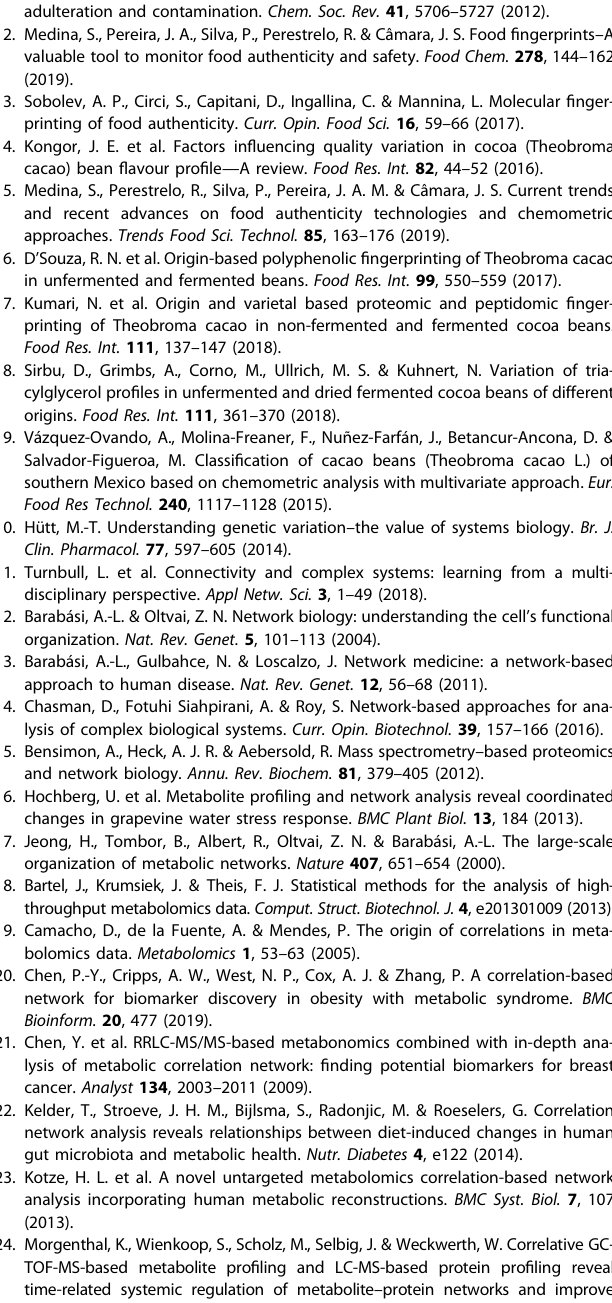
Salvador-Figueroa, M. Classi fi cation of cacao beans (Theobroma cacao L.) of southern Mexico based on chemometric analysis with multivariate approach.